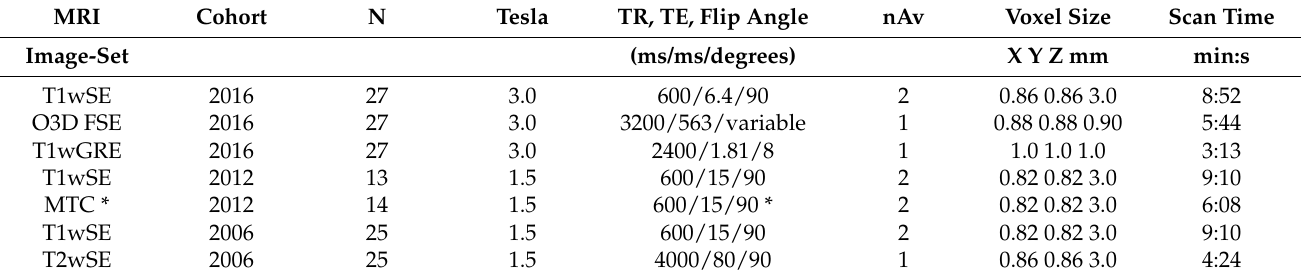
Table 2. MRI settings for seven healthy control image-sets across 3 cohorts and 5 MRI modalities. Each image-set is labelled by its year of acquisition. MRI image ‘O3D FSE’ refers to ‘Optimised 3D Fast Spin-Echo’ [12] called ‘T2 SPACE’ by Siemens. Gradient echo T1wGRE is also known as MPRAGE. N is number of HC subjects. The 2006 and 2012 cohorts were acquired on the same